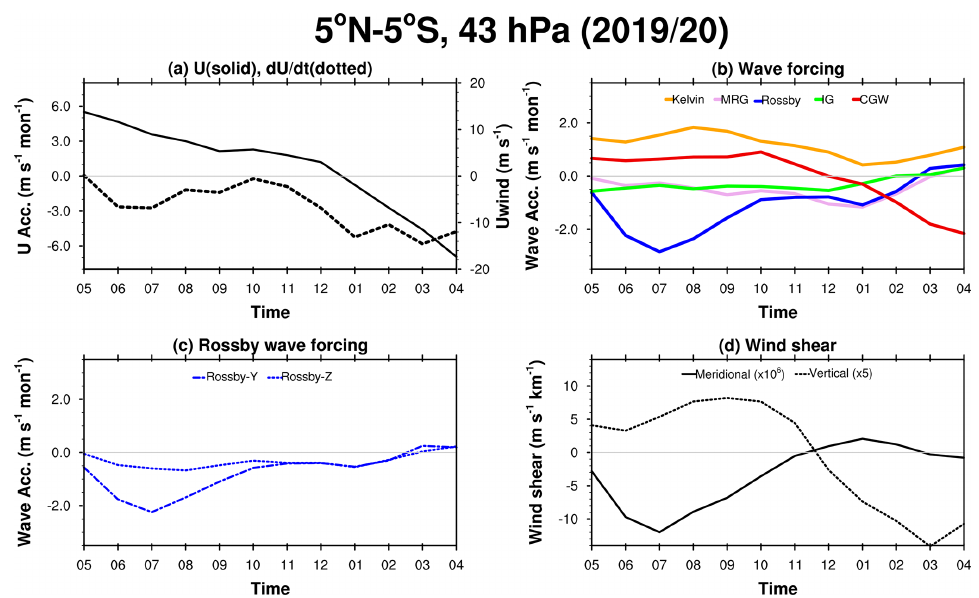
Figure 4. Monthly evolution of the (a) zonal-mean zonal wind (solid) and zonal wind tendency (dotted), (b) momentum forcing by the Kelvin waves (orange), MRG waves (pink), Rossby waves (blue), IG waves (light green), and CGWs (red) averaged over 5 ◦ N–5 ◦ S (dotted) at 43hPa from May 2019 to April 2020. (c) Momentum forcing by the Rossby waves decomposed into the meridional (dot-dashed) and vertical components (dotted). (d) Meridional wind shear across the Equator (solid) and vertical wind shear (dotted). Table 1. Monthly averaged momentum forcing by each wave type (ms − 1 per month) at 43hPa averaged for 5 ◦ N–5 ◦ S from June to January for the disruption period (2019/20) and the climatology. The ratio of each wave forcing to the total negative forcing is given in parentheses only when the wave forcing is